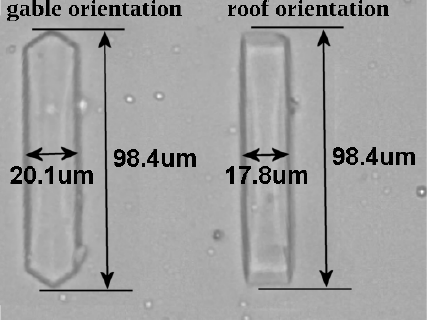
Figure 2. Image of the zeolite crystal in the